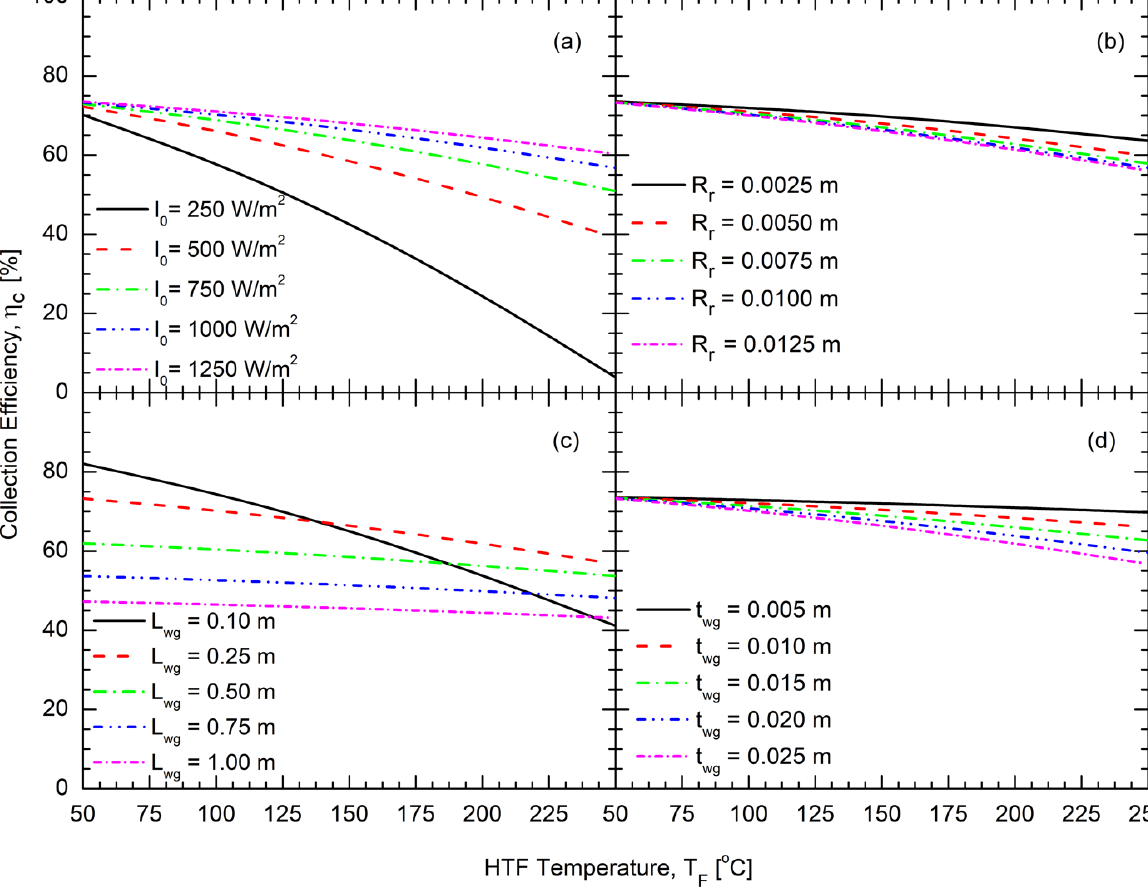
Figure 5. Influence of: ( a ) Incident solar radiation ( 𝐼 0 ), ( b ) receiver radius ( 𝑅 𝑟 ), ( c ) waveguide length ( 𝐿 𝑤𝑔 ), and ( d ) waveguide thickness ( 𝑡 𝑤𝑔 ) on the collection efficiency.